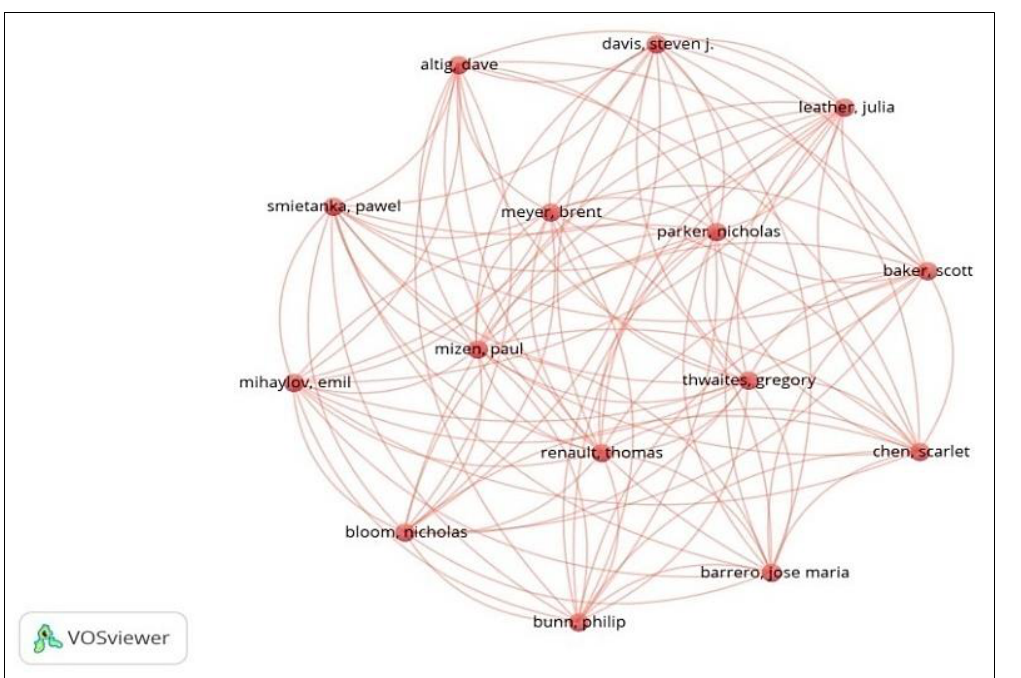
Figure 2. Network Visualization of connected